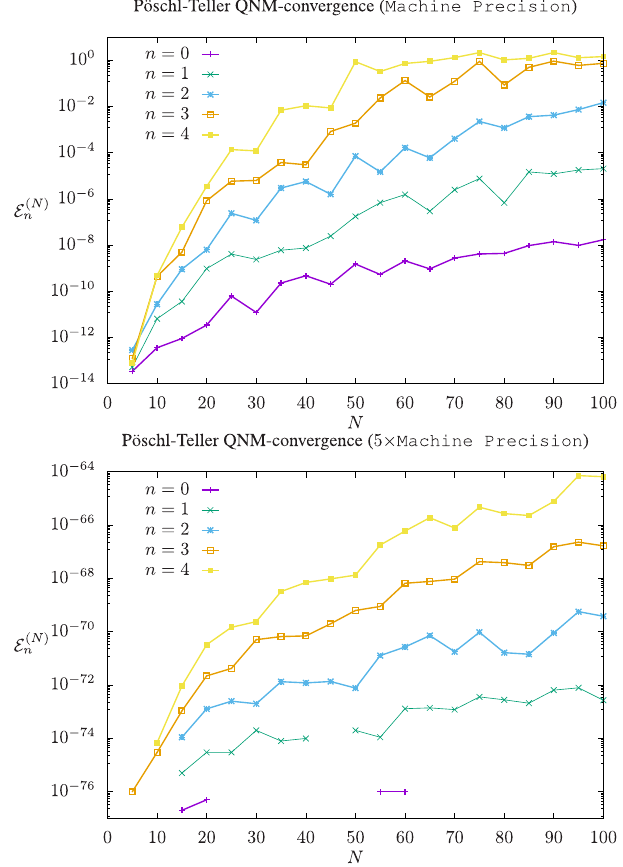
FIG. 4. Convergence test for the Pöschl-Teller QNM. Top panel: double floating point operations with internal roundoff error set to machine precision. Bottom panel: double floating point operations with internal roundoff error set to 5 × machine precision. Note that missing points for n ¼ 0 correspond to errors that exactly vanish at the employed machine